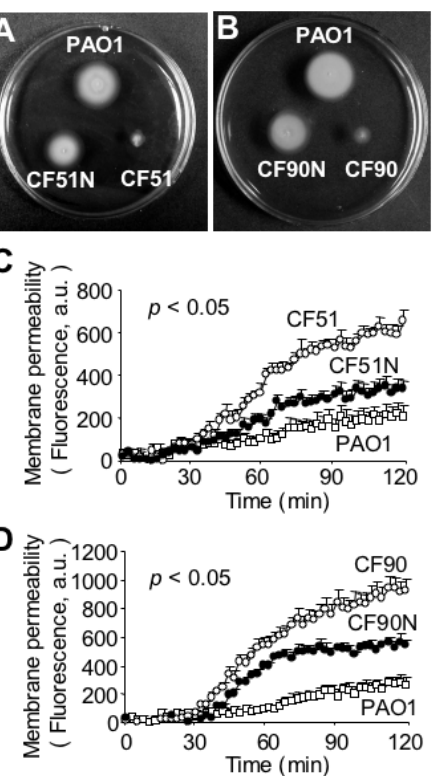
red. As shown in Figure 5A, SP-A did not kill wild-type PA01 (green stained). In contrast, mixtures of green- and red-stained cells of flgE were visible following treatment with SP-A.